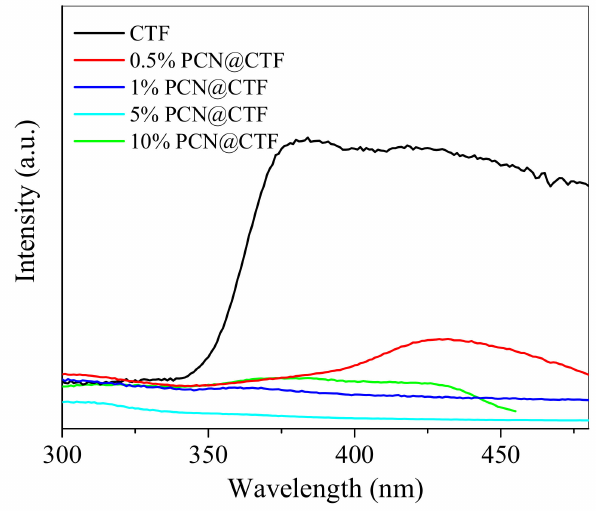
Figure 7. Stable photoluminescence spectra of CTF and x %PCN@CTF.